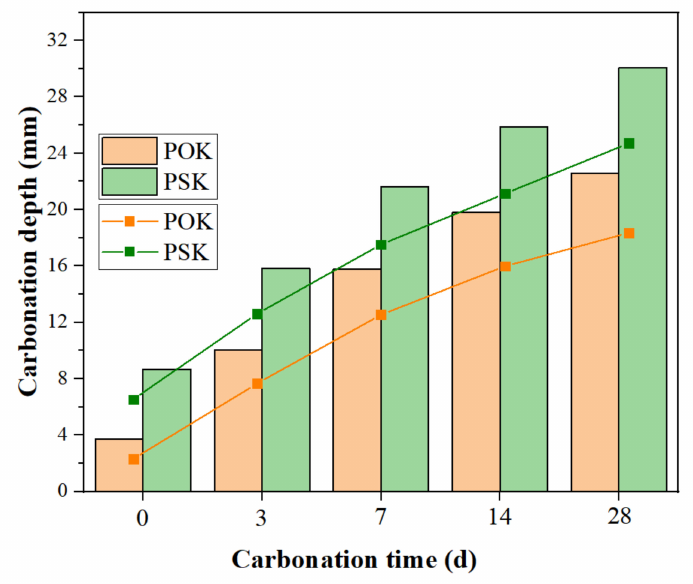
Figure 4. Relationship between carbonation depth and curing time of